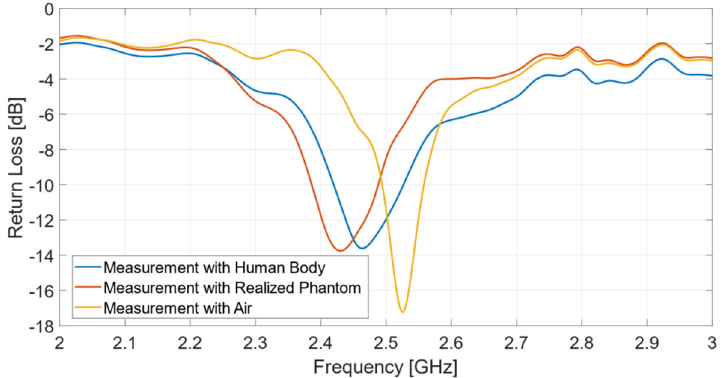
Figure 7. Return loss measurements: comparison between multi-layer phantom and human body.